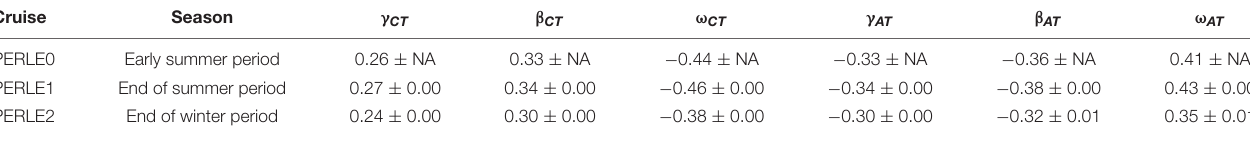
TABLE 4 | Mean values and standard deviations of buffer factors (in mmol.kg − 1 ) during PERLE cruises.